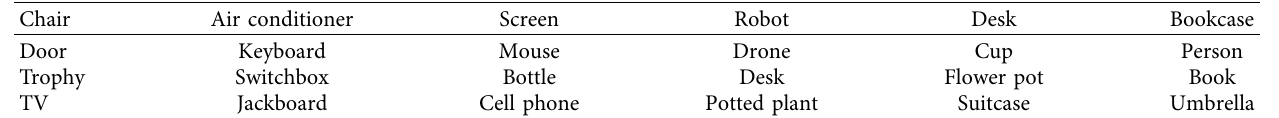
Table 2: Selection for 24 types of objects.